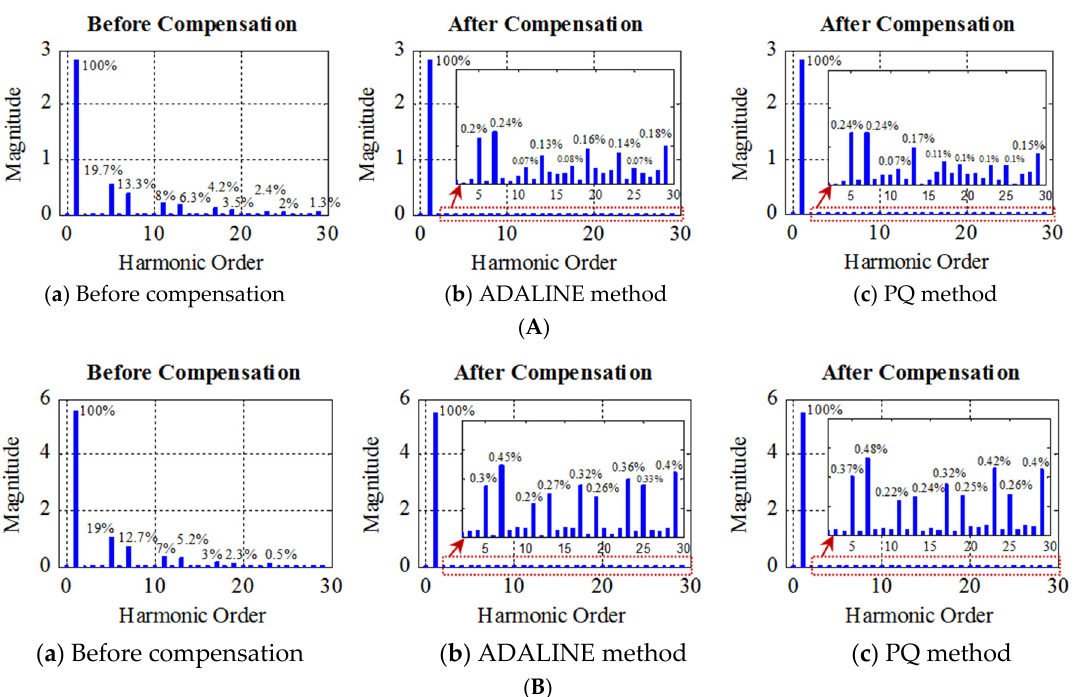
Figure 14. Spectrums of the source current for Case 3: ( A ) Signals at intervals 0 ≤ Time < 0.25 s; ( B ) Signals at intervals 0.25 ≤ Time < 0.5 s.